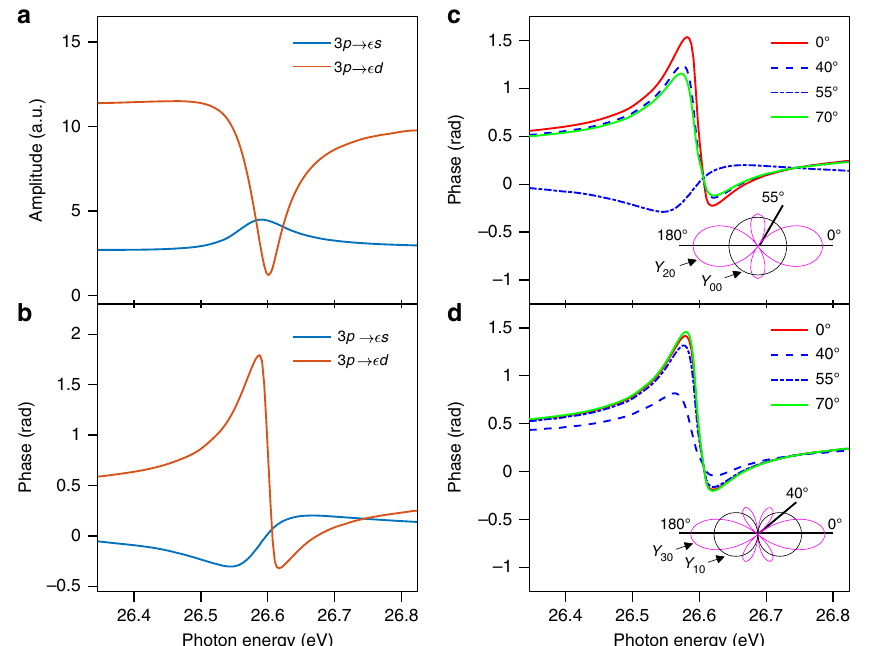
Fig. 7 Amplitude and phases for one and two-photon transitions. Amplitude (in atomic units) ( a ) and phase ( b ) of one-photon ionization for the 3 p → ε s (blue) and 3 p → ε d channels close to the 3 s − 1 4 p autoionizing state 46 . Phase variation as a function of energy for one-photon ( c ) and two-photon ( d ) ionization, calculated according to Eq. (7). Note that the x axes in this fi gure refers to the photon energy of the 17th harmonic (single photon transition), whose position is spanned across the 4 p resonance. The spherical harmonics involved are indicated as an